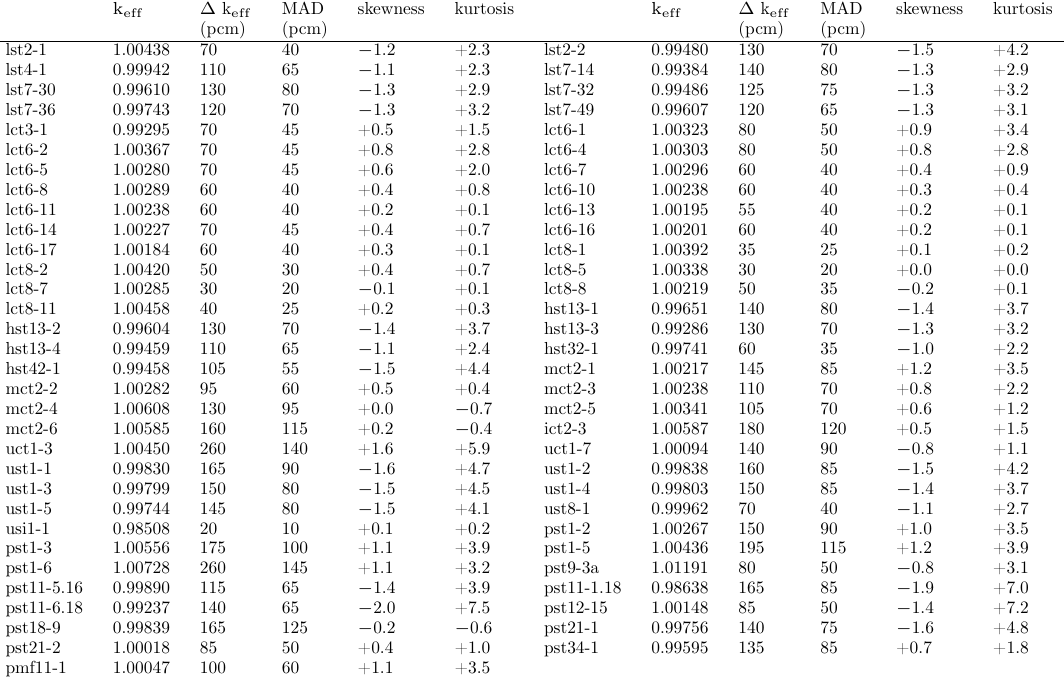
Table 1. Uncertainties (standard deviation and MAD), skewness and kurtosis on criticality benchmarks due to thermal scattering data of H in H 2 0 obtained from MCNP6 calculations. The base library (except the thermal scattering data) is JEFF-4.0 β . The statistical uncertainties are already